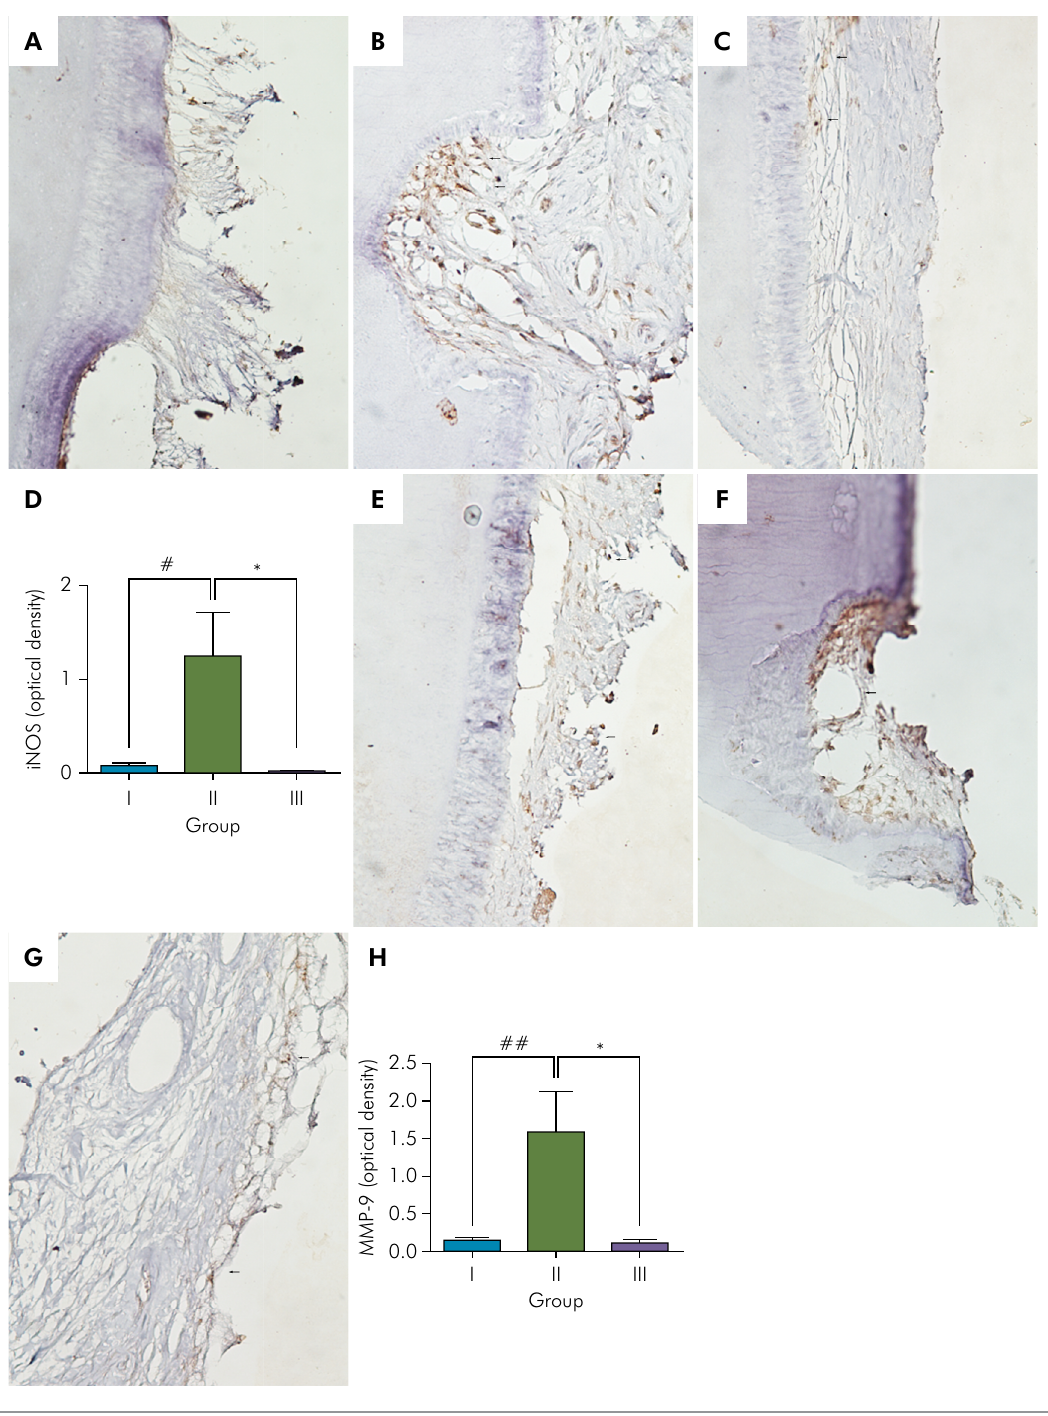
Figure 3. Expression of iNOS and MMP-9 in PDL of human deciduous and permanent teeth; (A) moderate expression of iNOS in area of root resorption in apical fragment in Group I (magnification: 400x); (B) Strong expression if iNOS in Howship lacunae in the PDL in Group II (magnification: 400x); (C) mild expression of iNOS in PDL in Group III (magnification: 400x); (D) comparison of iNOS expression in periodontal tissue in different groups; (E) expression of MMP-9 in PDL of cervical fragment in Group I much less intense than (F) in Howship lacunae in cementum and dentine of apical fragment in Group II (magnification: 400x); (G) mild labelling of MMP-9 in PDL in Group III (magnification: 400x); (H) comparison of MMP-9 expression in periodontal tissue in different groups; data expressed as mean ± SEM of 10 teeth/group; #p < 0.05 and ##p < 0.001 versus Group I and *P<0.05 versus Group II (one-way ANOVA, followed by Student-Newmann-Keuls post hoc test); immunohistochemical analysis from A to C and E to G.